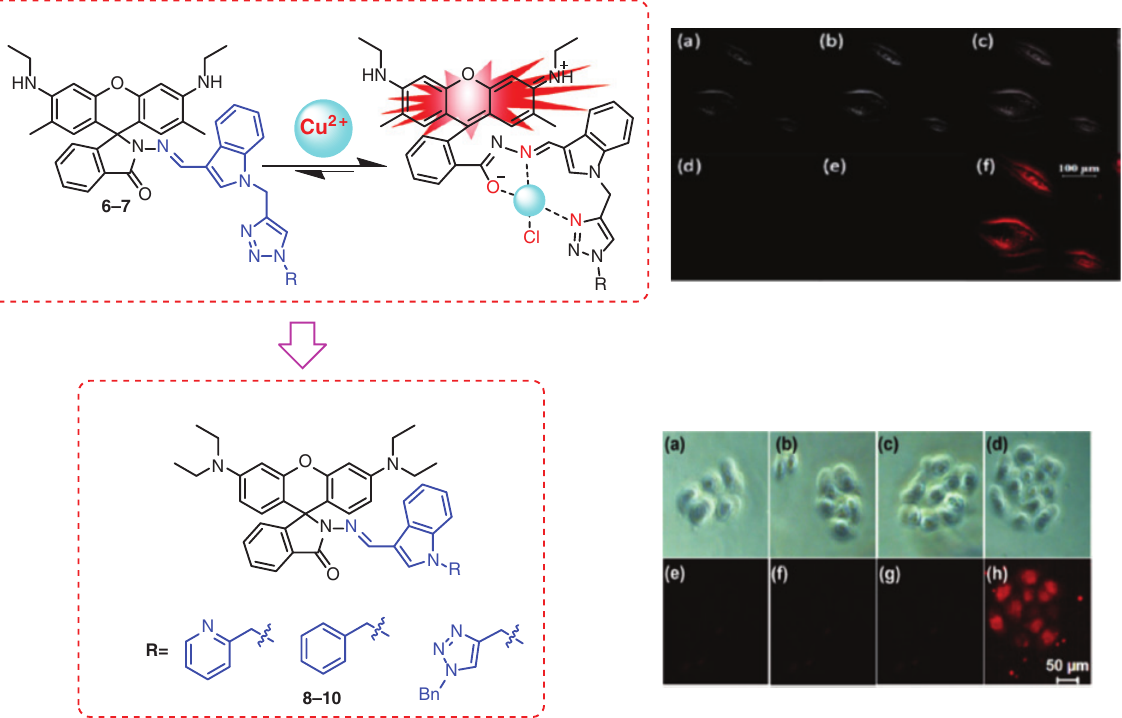
Figure 8: Fluorescent images of live keratinocyte cells incubated with probes 7 and 10 . Reprinted from Chereddy et al.